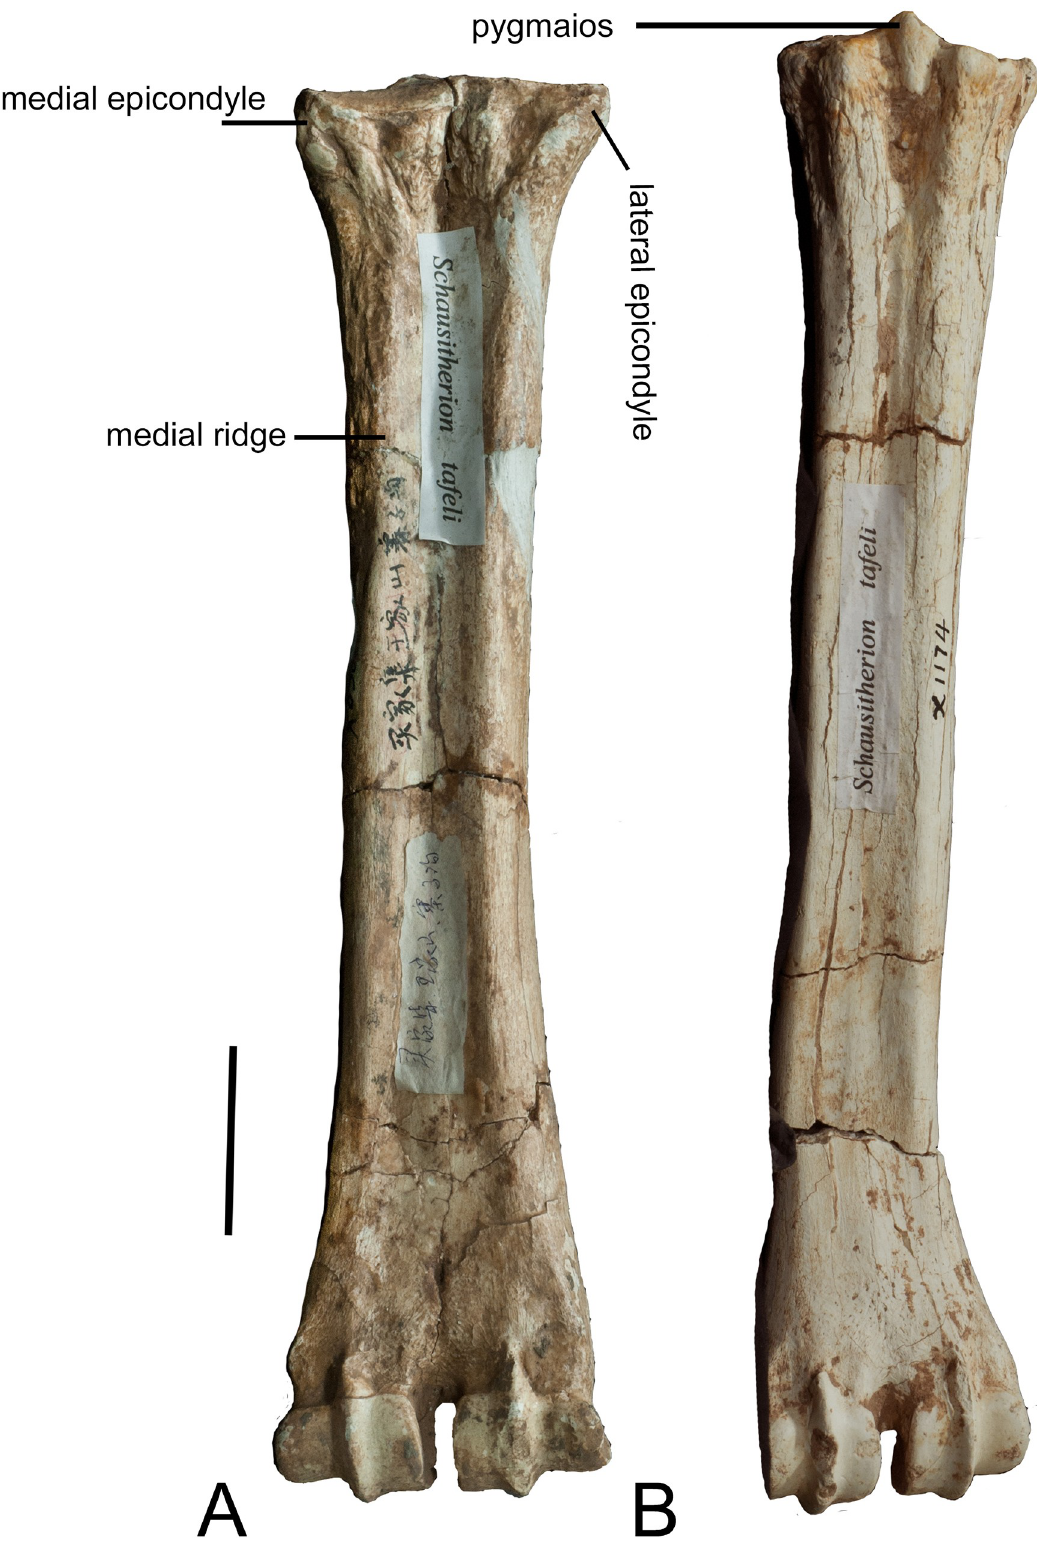
Fig 12. Schansitherium tafeli. (A) Ventral view of right metacarpal HMV 1951. (B) Ventral view of right metatarsal HMV 1986. Scale 50mm. https://doi.org/10.1371/journal.pone.0211797.g012 PLOS ONE | https://doi.org/10.1371/journal.pone.0211797 February 12,